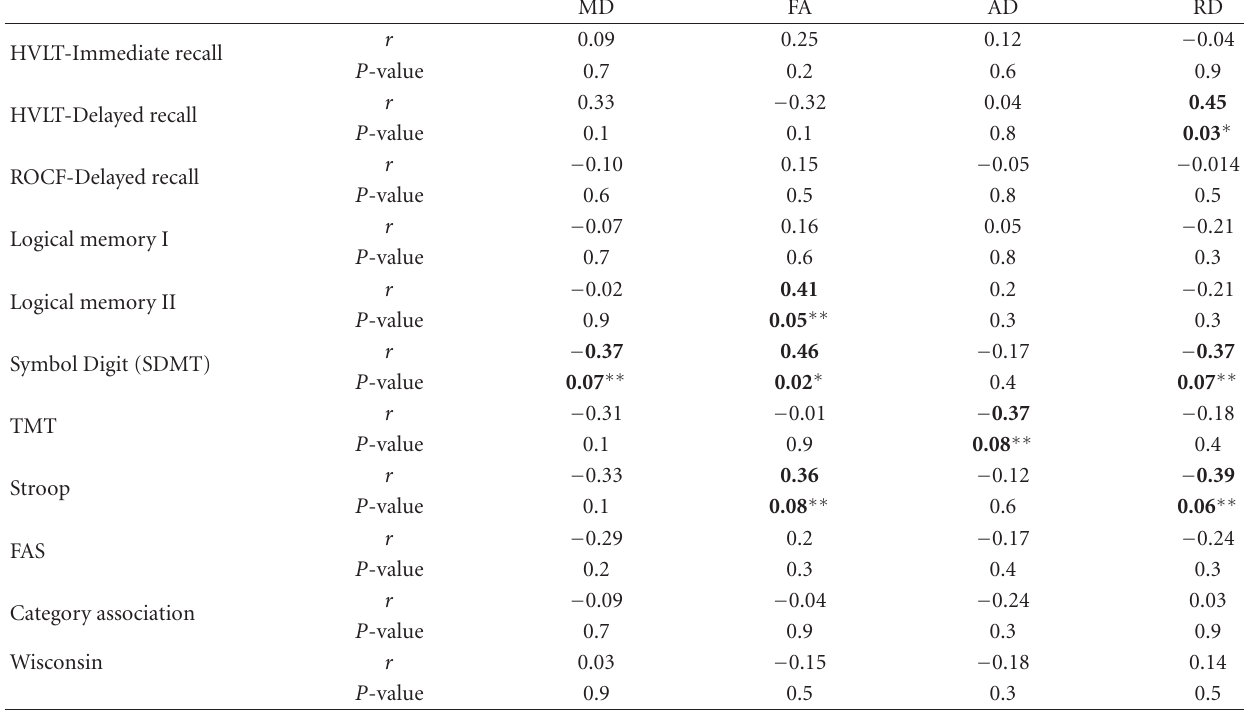
Table 4: Pearson’s correlation test between the main cognitive tasks and DTI parameters (considering z scores of all MS